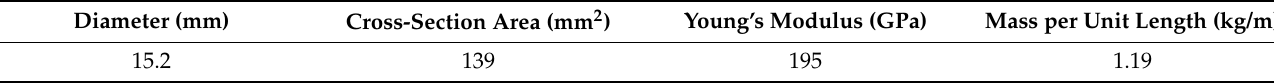
Table 2. Specifications of the strand.